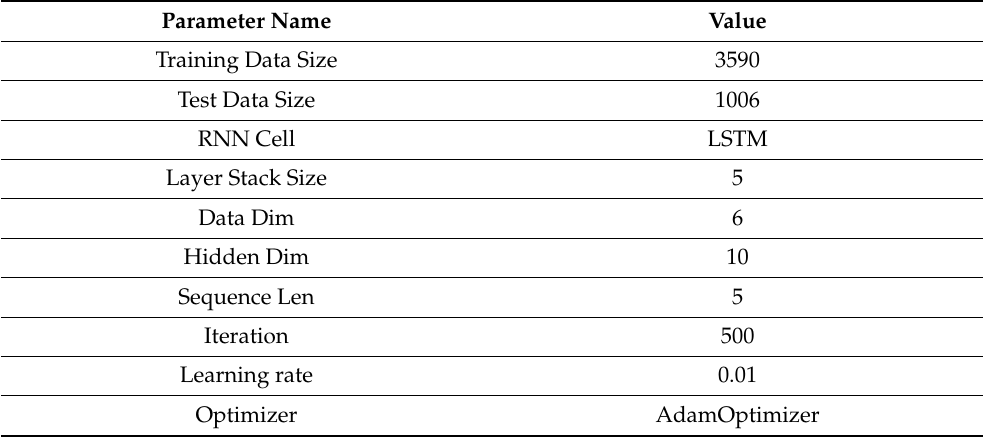
Table 15. Parameters defined to facilitate the training of the recurrent neural network model.